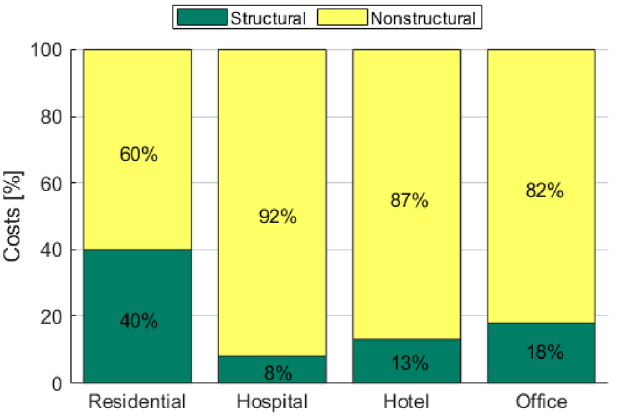
Figure 1. Cost breakdown of RC residential buildings, office buildings, hotels, and hospitals [9,10].